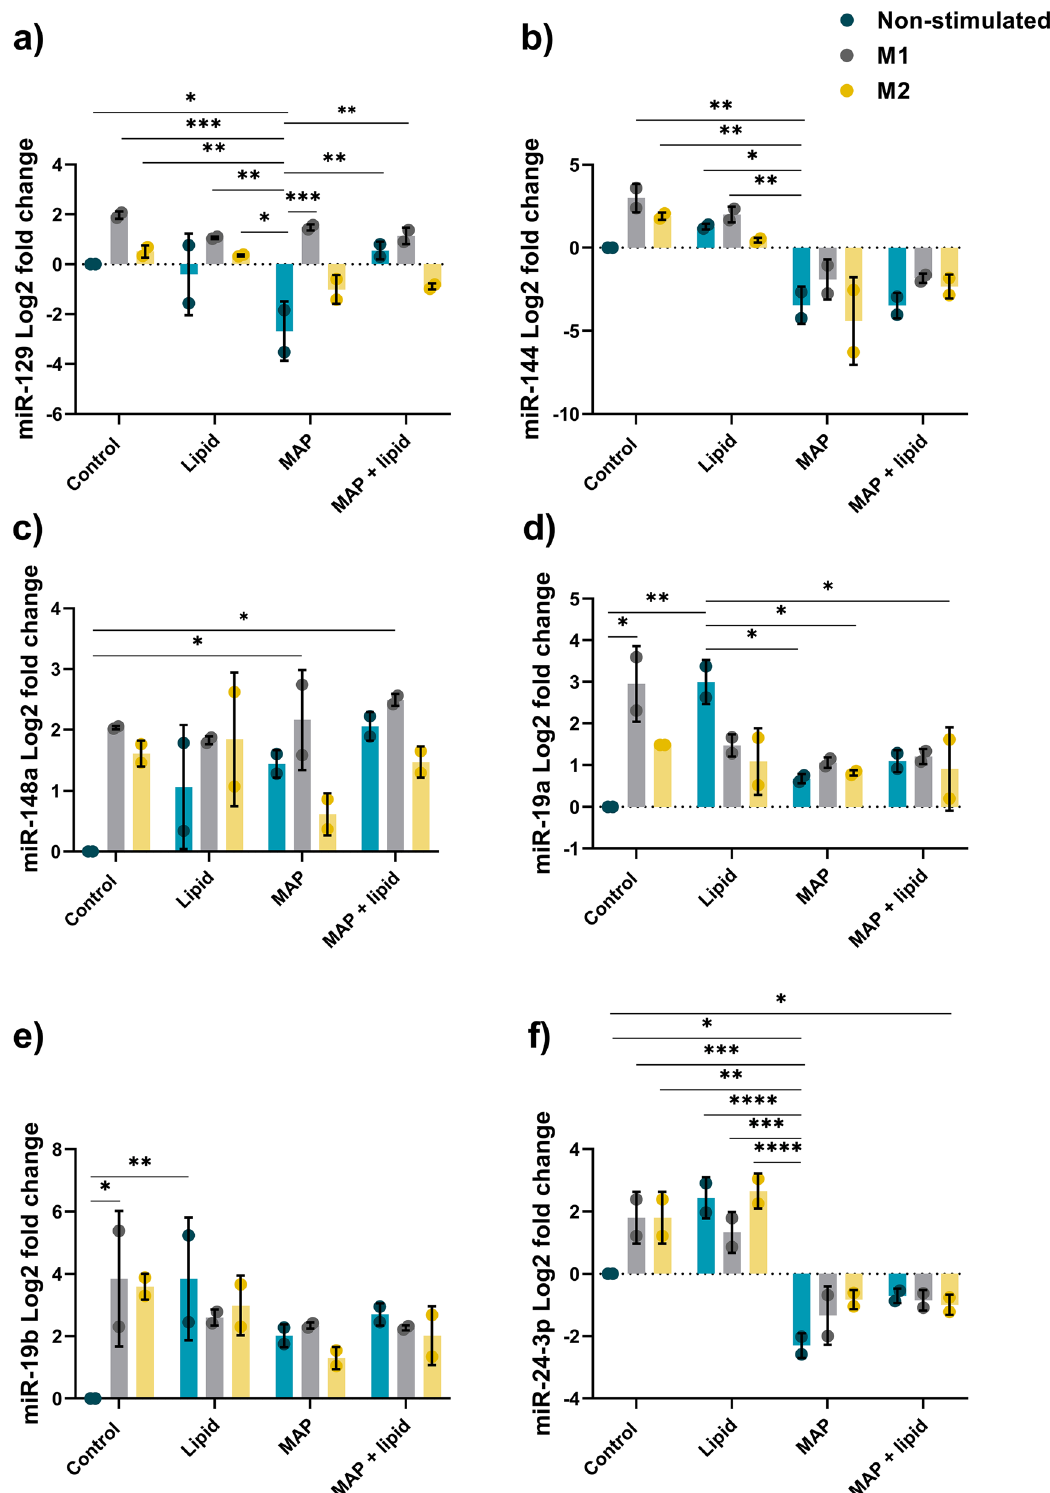
Figure 3. miRNA expression in MAP infected murine macrophages. RAW264.7 macrophages were infected with MAP with or without lipid supplementation. miRNA expression was analysed by qPCR at 24 hpi. ( a ) miR- 129 fold change, ( b ) miR-24-3p fold change , ( c ) miR-144 fold change, ( d ) miR-24 fold change, ( e ) miR-19a fold change, ( f ) miR-148a fold change. Columns represent the mean fold change from control uninfected cells and error bars indicate the standard deviation, while asterisks indicate significantly different fold changes (*p ≤ 0.05, **p ≤ 0.01, ***p ≤ 0.001, ****p ≤ 0.0001). Graph is representative of 2 biological replicates and 2 technical